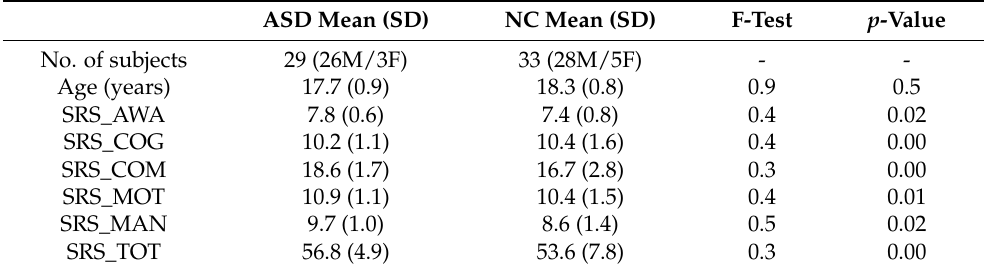
Table 2. Demographic and mean value ± standard deviation (SD) of clinical diagnostic SRS scores of LEUVEN